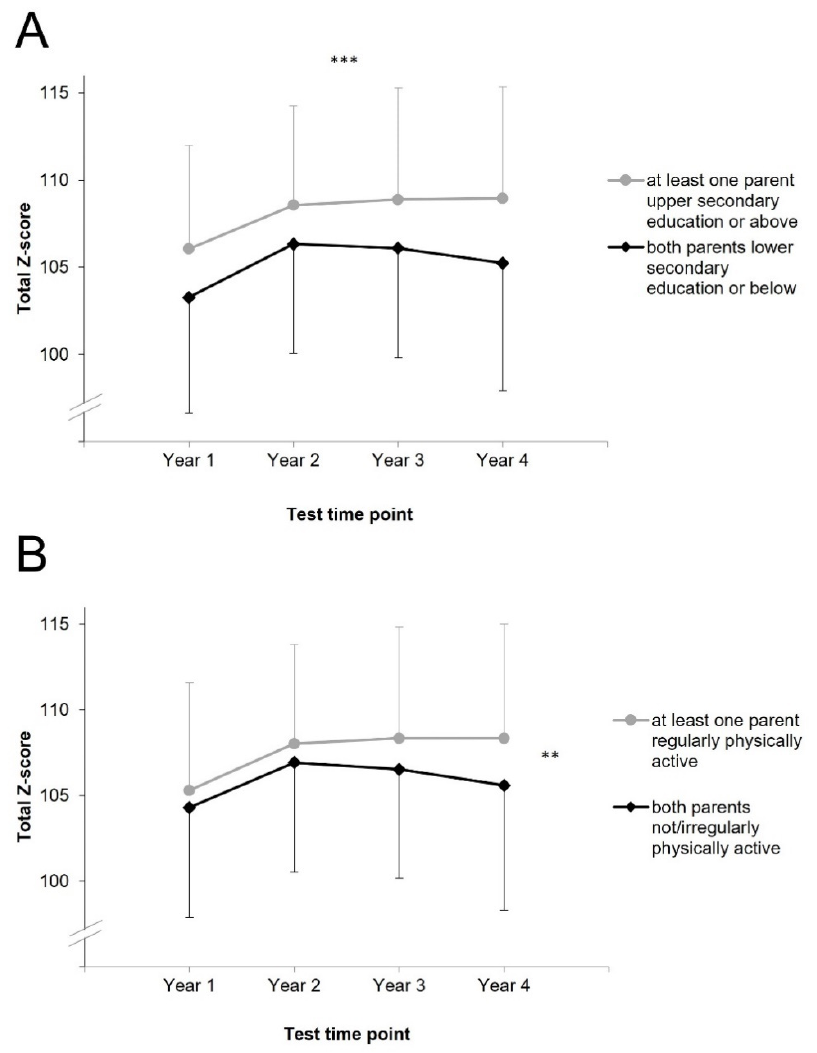
Figure 1. Children’s mean physical fitness values by parental education ( A ) and by parental physical activity ( B ), case wise missing. Error bars represent standard deviations. ***: indicates a significant main effect of parental education, **: indicates a significant interaction effect of parental physical activity x time according to the results of analysis of (co)variance (not significant according to multilevel modelling analysis).